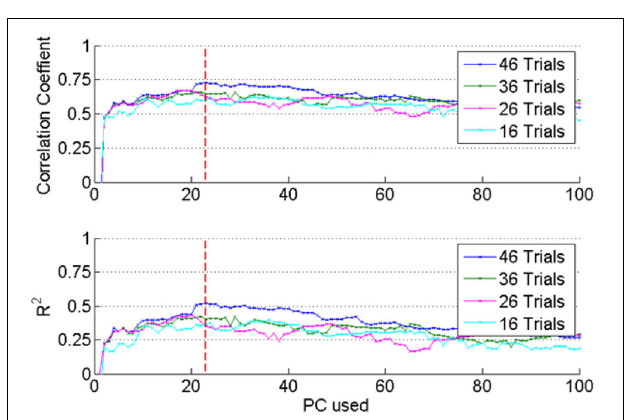
FIGURE 6 | The optimum regression coefficients were determined by increasing the number of PCs and the number of trials included into the analysis from a session. Top plot : correlation ( R ), bottom : R 2 values obtained by applying the regression coefficients to the test set. Both R and R 2 increased with increasing number of PCs up to the dashed vertical line. This procedure prevented over-fitting the data in the training